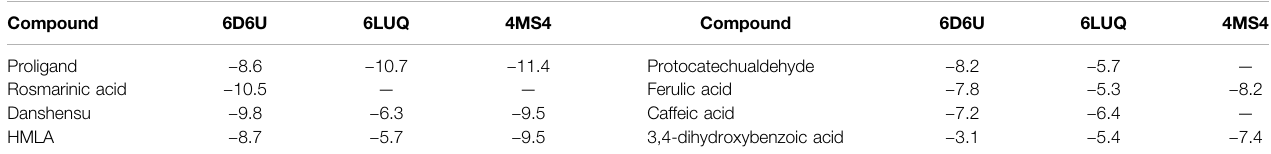
TABLE 5 | Molecular docking results of 7 prototype components absorbed into the brain from Shuangxia decoction. Compound